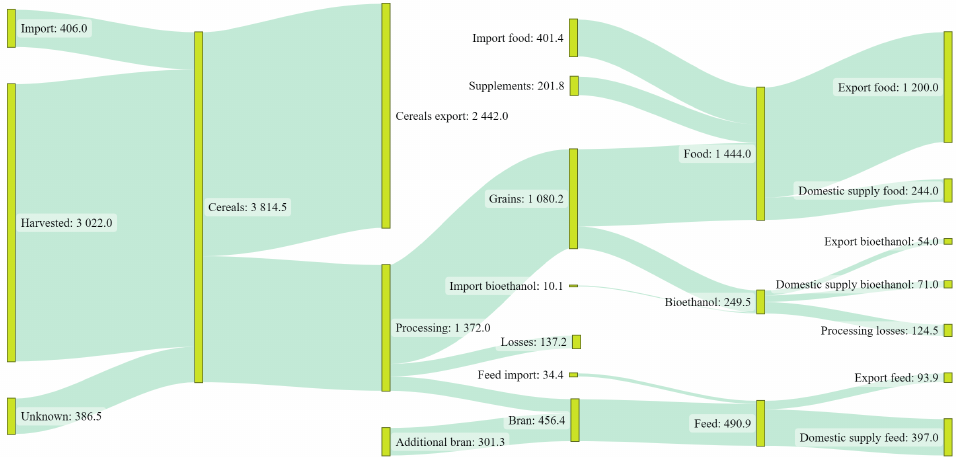
Fig. 2. Sankey diagram for bioresource flows of base scenario in 2015 for cereals, thousand